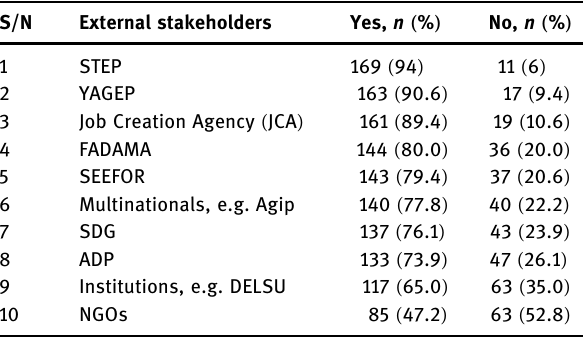
Table 2: External stakeholders ’ roles in livestock